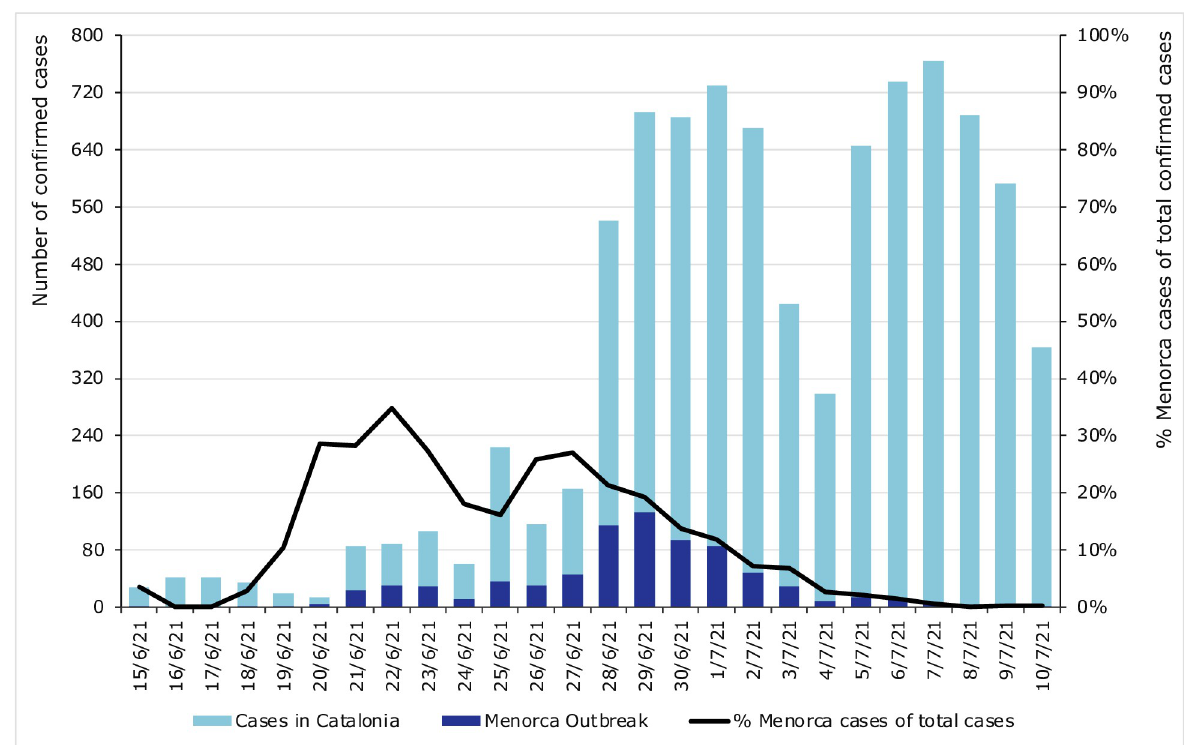
Fig 5. Number of confirmed cases of Covid-19 aged 17–19 in Catalonia during Menorca outbreak and percentage of confirmed cases related with Menorca’s outbreak, Catalonia, June and July of 2021.